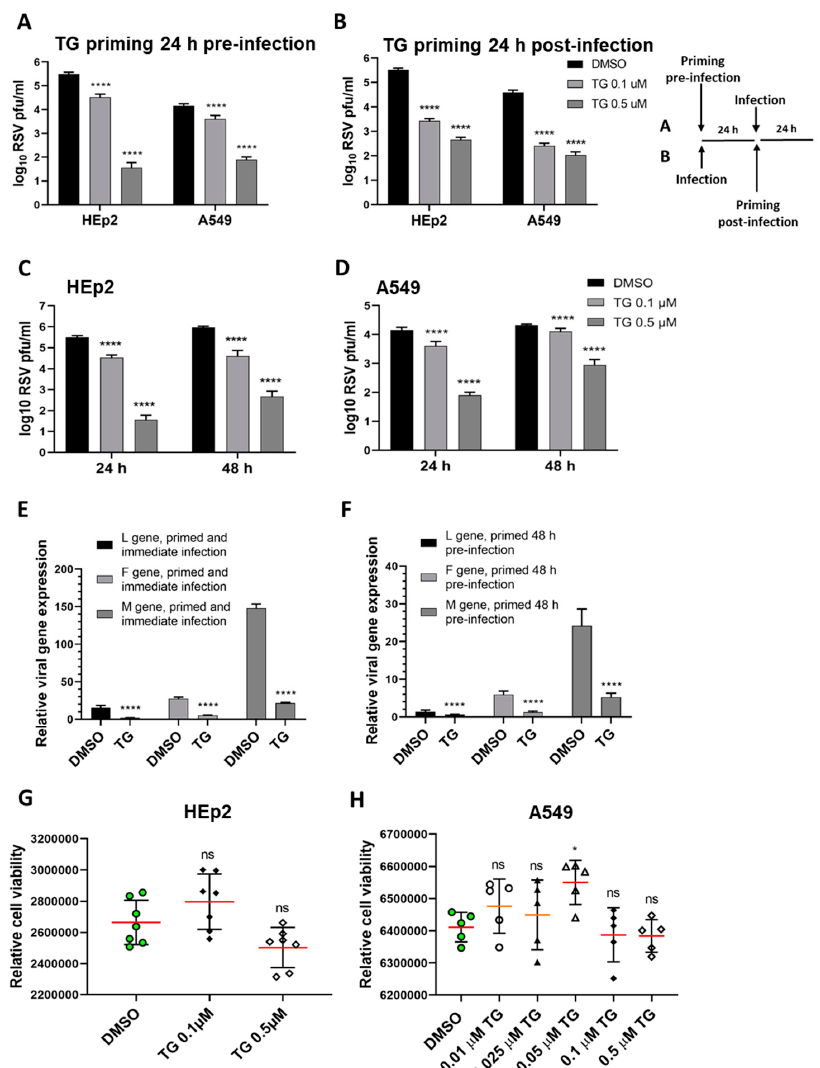
Figure 1. Short exposure (30 min) of thapsigargin (TG) to human cells, at non-cytotoxic levels, promptly elicits a prolonged ( ≥ 48 h) antiviral state that blocks RSV replication. TG priming 24 h before ( A ) or 24 h after ( B ) infection, in a dose-dependent manner, blocks RSV production. ( A ) HEp2 and A549 were primed with TG or control DMSO for 30 min, washed with PBS and incubated in normal culture media for 24 h before RSV infection, or ( B ) were initially infected with RSV for 24 h before 30 min of TG priming. The TG-induced antiviral state lasted at least 48 h. HEp2 ( C ) and A549 ( D ) cells were primed with TG or DMSO control for 30 min, as indicated, washed with PBS and allowed a further period of 24 or 48 h of normal culture; after which cells were infected with RSV. All cells were infected with RSV (A2 strain, ATCC VR-1540) at 0.1 MOI for a total duration of 3 days. The spun supernatants were collected to infect HEp2 cells for 24 h for immuno-detection of RSV with mouse anti-RSV (2F7) antibody (pfu/mL). Significance by 2-way ANOVA (Sidak’s multiple comparisons) is relative to the corresponding DMSO control. HEp2 cells were more permissive to RSV replication than A549 cells. TG inhibited RSV transcription. HEp2 cells were ( E ) primed for 30 min with 0.5 µM TG immediately before RSV infection, and ( F ) primed with TG for 30 min, washed with PBS and cultured for a further period of 48 h before RSV infection. After a total of 3 days of infection, total RNA was extracted for cDNA conversion to quantify viral gene (L-gene, M-gene and F-gene) expression normalised to 18s rRNA. Significance was determined by unpaired t -test relative to expression in the corresponding DMSO control. ( G ) HEp2 and ( H ) A549 cells pre-incubated with indicated concentrations of TG or DMSO control for 30 min were washed with PBS, cultured overnight in serum-free media (Opti-MEM) and subjected to cell viability assays (CellTiter-Glo ® Luminescent Cell Viability Assay kit, Promega). Horizontal bars = mean (red) ± standard deviation; ns = not significant. Significance by one-way ANOVA with Dunnett’s multiple comparisons is relative to the corresponding DMSO control. All assays were in triplicates and were performed three times. * p < 0.05 and **** p < 0.0001.